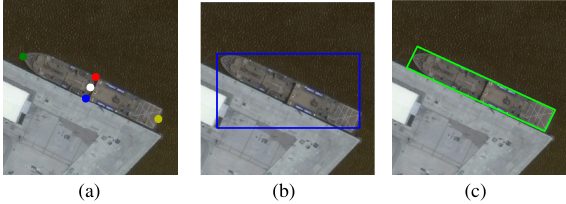
Figure 1. An example of the five keypoints of a ship and the derived ship detection results. (a) The definition of the ship keypoints: one point located at the center of the ship and four other points located at the head, the tail, the midpoint of the left side and the midpoint of the right side, respectively. (b) The regular rectangular bounding box derived from the